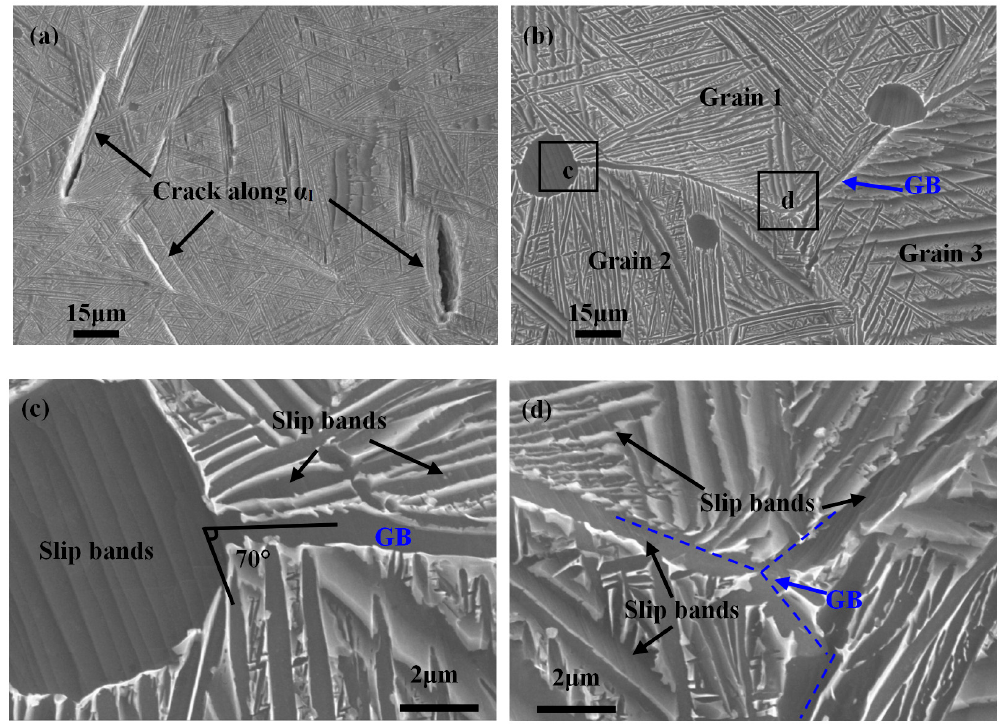
Figure 5. The plastic deformation and crack initiation behavior of the TM: ( a ) the crack initiates in α l ; ( b ) the equiaxed alpha phase ( α p ) in the β GB; ( c ) the multi-slip bands in the globular α phase, ( d ) the dislocation slip bands occur both in the GB α phase and α l ; the plastic deformation is not confined to the GB α phase.